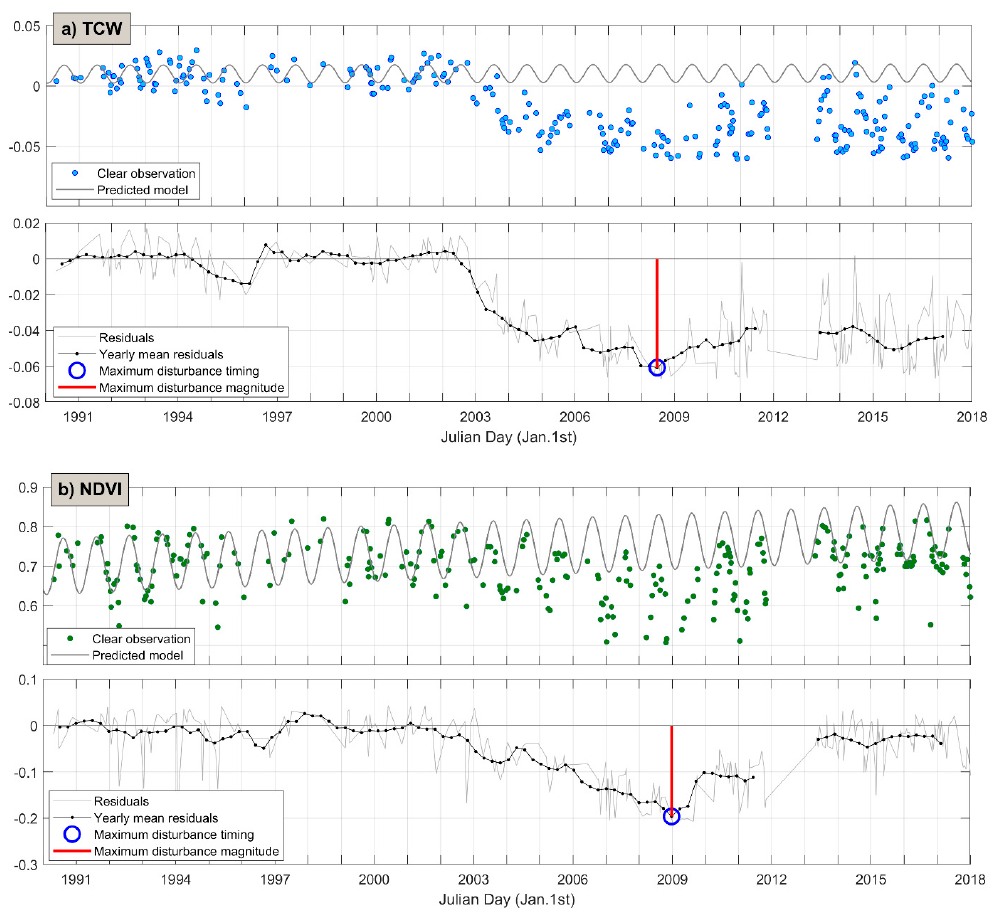
Figure 5. The spectral trajectories of ( a ) TCW and ( b ) NDVI, their residuals (light grey line), and mean values within 1-year moving windows with 3-month steps (solid line with dots in lower panels) at a Hemlock Woolly Adelgid (HWA)-defoliated Landsat pixel with 12 dead hemlocks. The residuals were the difference between the observed and projected values (dark grey lines) fitted by Equation (1) before 2000. The maximum disturbance magnitude (red lines) and its timing (blue circles) are shown in the mean residuals’ trajectories.